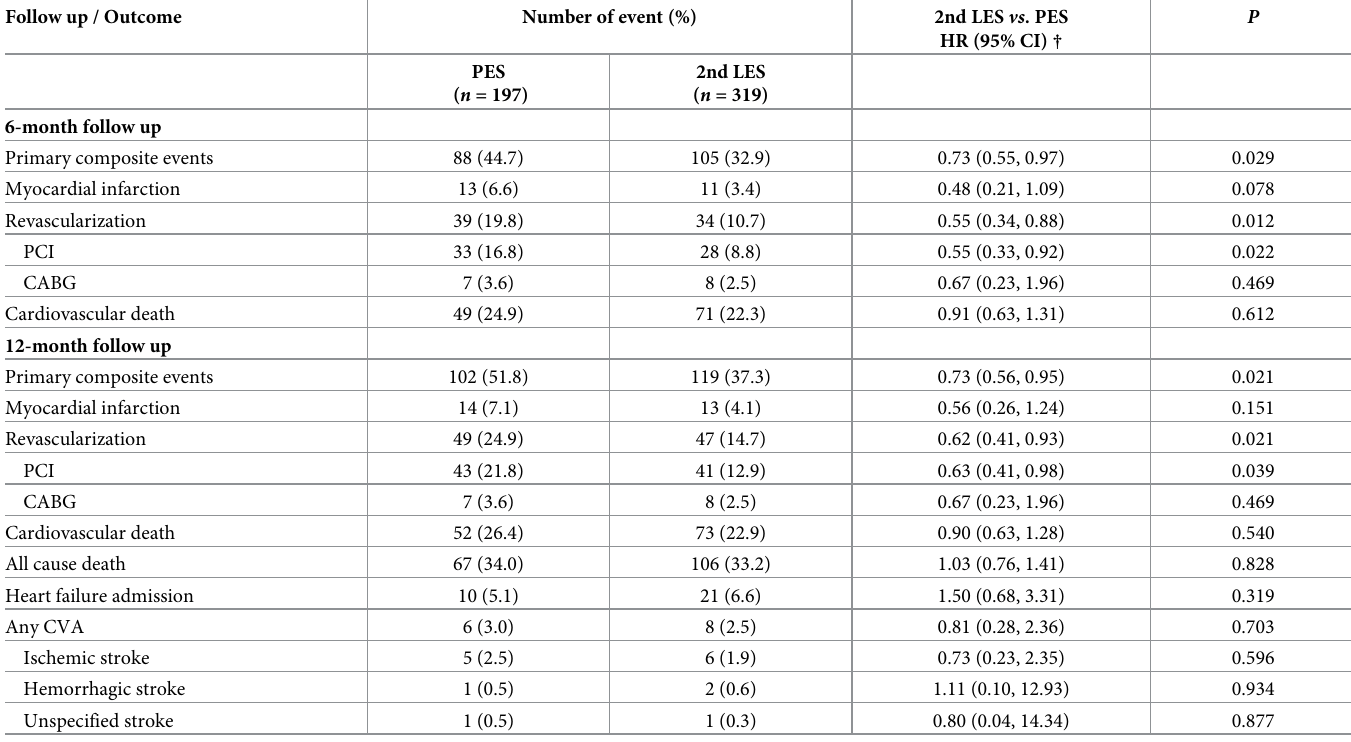
Table 2. Clinical outcome at various follow-up